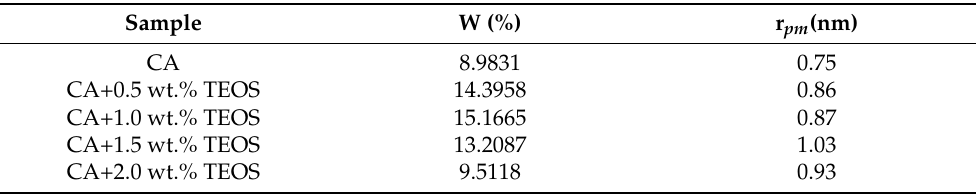
Table 6. Surface parameters evaluated based on adsorption/desorption isotherms: water vapor sorption capacity; W, final weight; r pm , and average pore size.